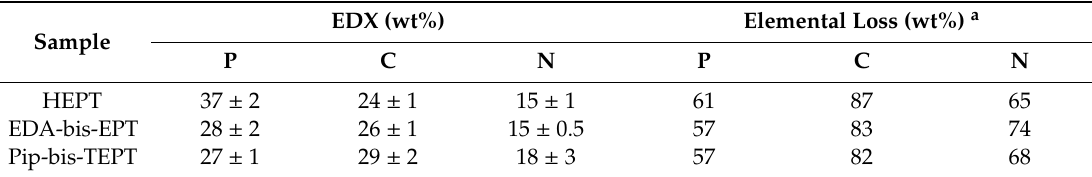
Table 3. Elemental analysis of the char residue after TGA under air. EDX—energy-dispersive X-ray